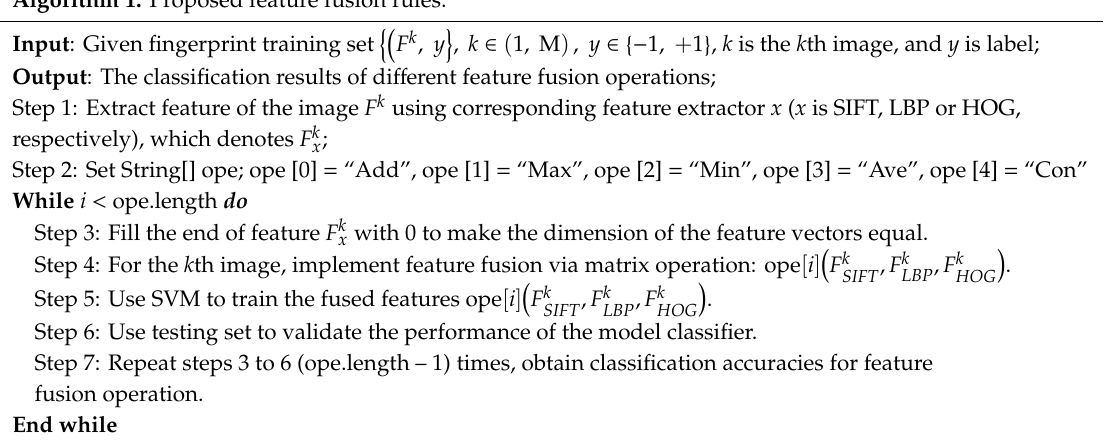
Algorithm 1. Proposed feature fusion